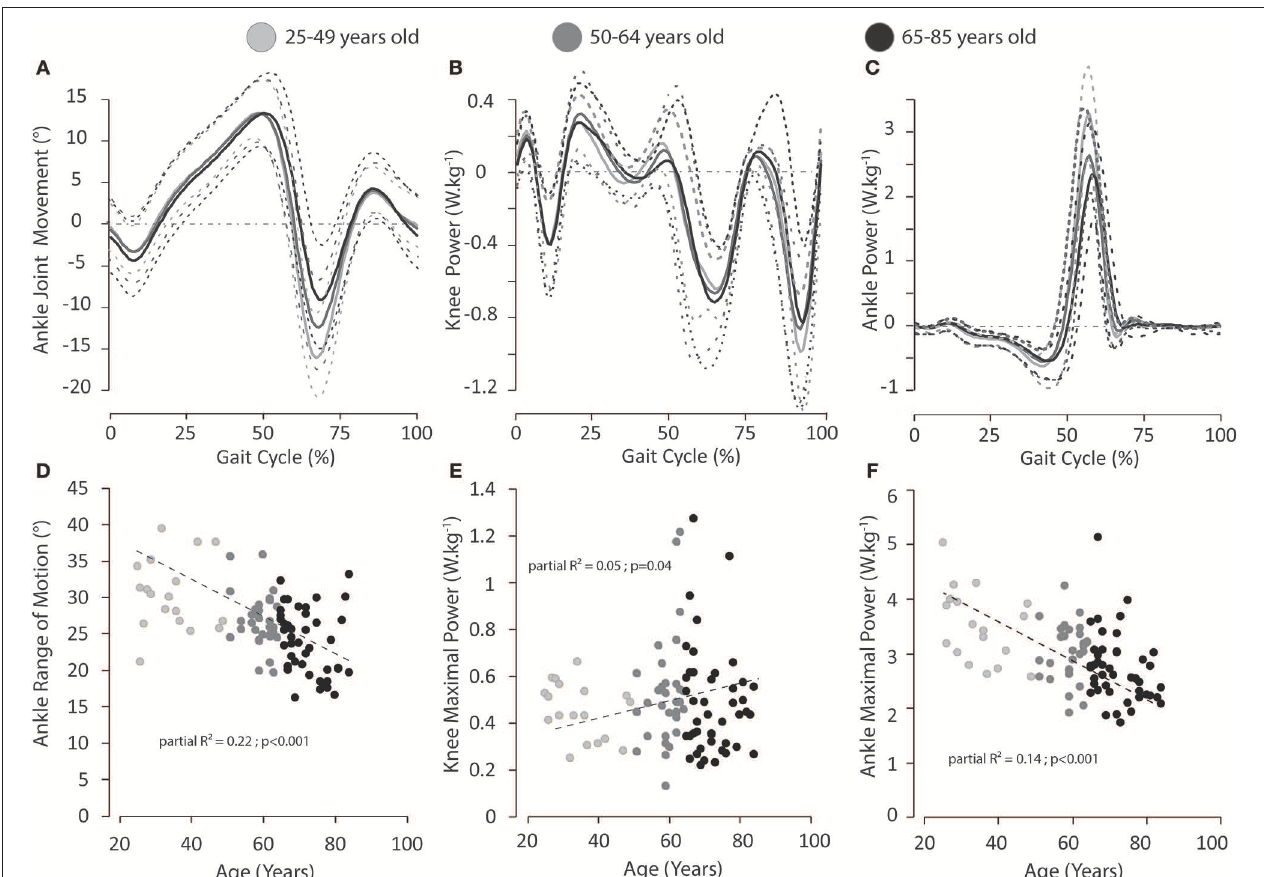
FIGURE 2 | (A) Mean (solid lines) and standard deviation (dotted lines) waveforms of sagittal ankle joint excursions for people of 25–49 (light gray)/50–64 (medium gray)/65–85 (dark gray) years old. (B) Mean waveforms of knee power for people of 25–49 (light gray)/50–64 (medium gray)/65–85 (dark gray) years old. (C) Mean waveforms of sagittal ankle power for people of 25–49 (light gray)/50–64 (medium gray)/65–85 (dark gray) years old. Relationships between age and ankle range of motion (D) , knee maximal power (E) , ankle maximal power (F) . Partial R ² and p -Value are provided. We choose to represent 3 classes of age in order to highlight change due to